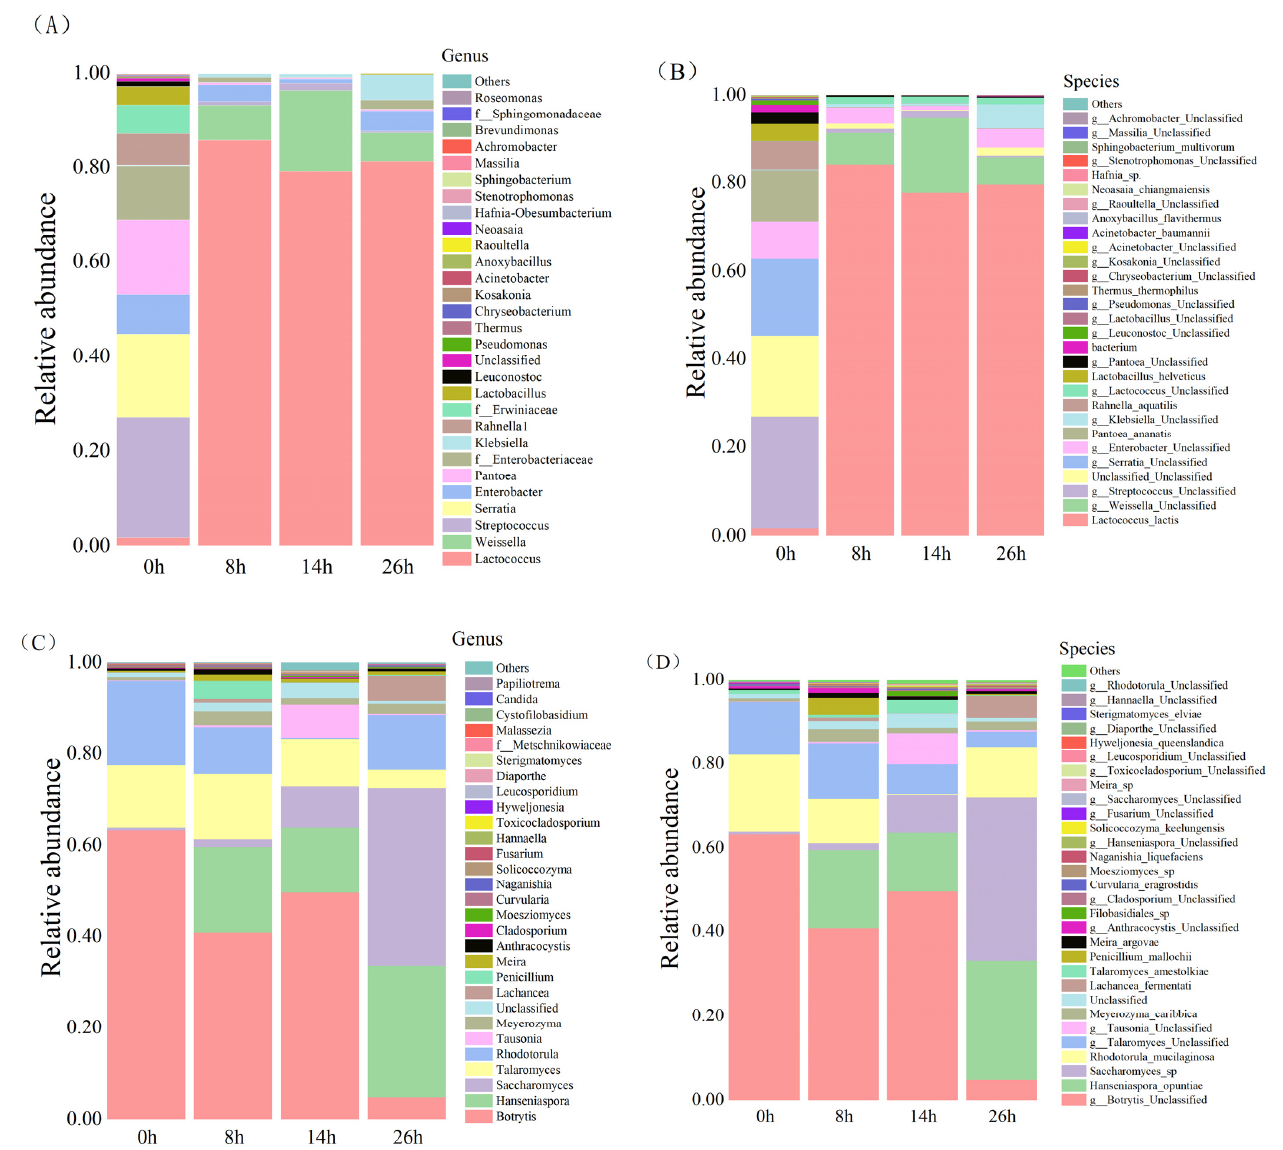
Figure 2. Relative abundance of bacterial ( A ) bacterial genus; ( B ) bacterial species and fungal ( C ) fungal genus; ( D ) fungal species populations of fermented products at different fermentation stages.